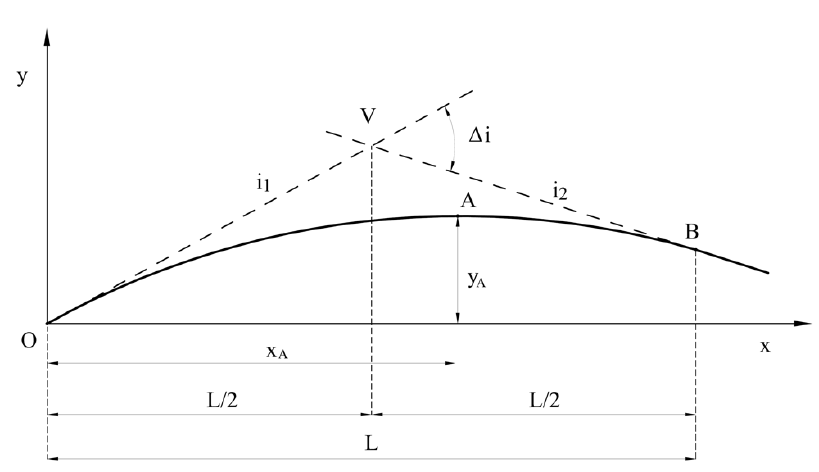
Figure 3. Parameters considered in determining the crest vertical curve radius.